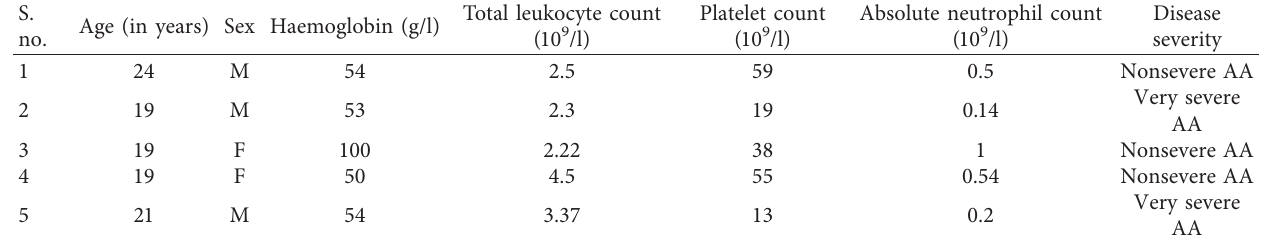
Table 1: Characteristics of acquired aplastic anemia patients.